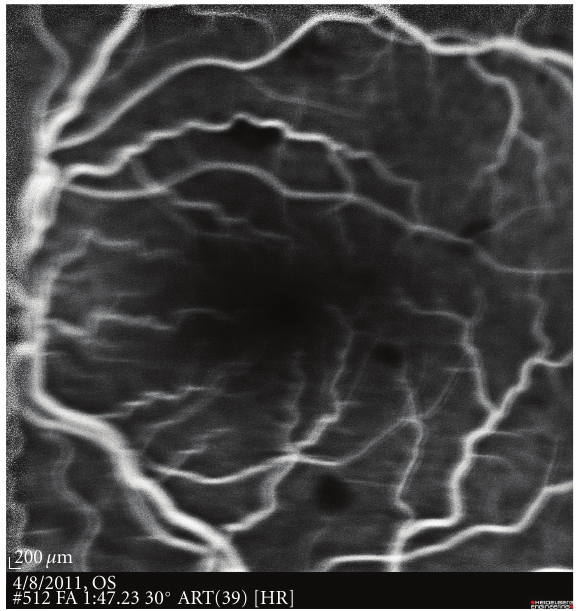
Figure 2: Late phase of a fluorescein angiogram demonstrates blocking defects due to overlying retinal